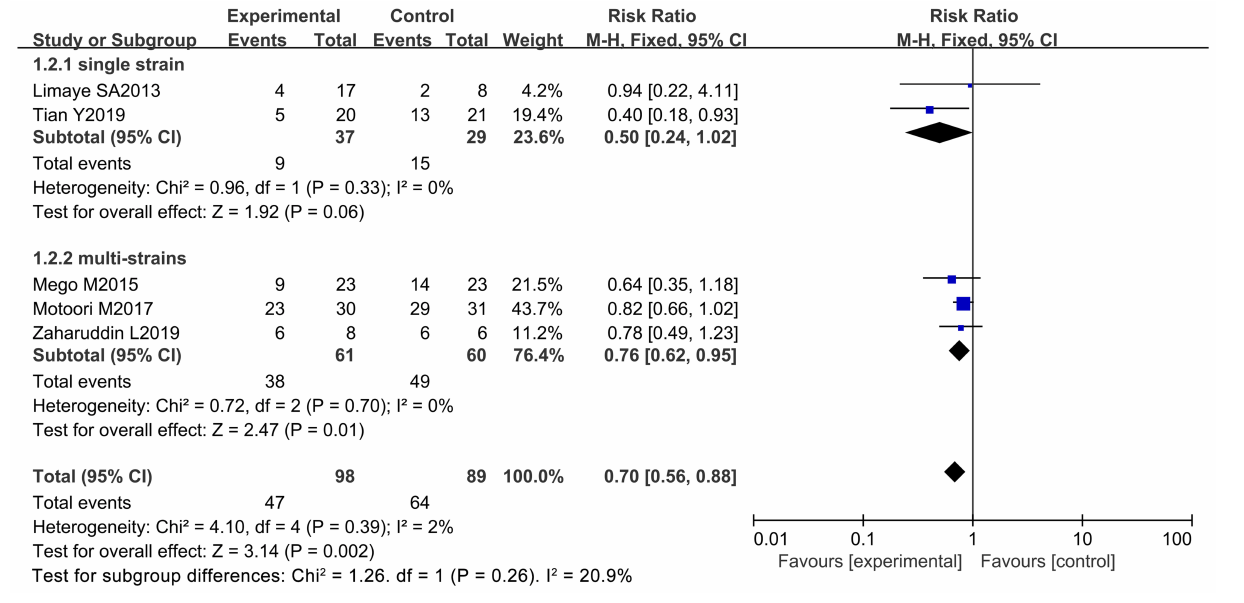
FIGURE 10 | Subgroup analysis of the effect of the bacterial number on the incidence reduction of diarrhea in cancer patients.